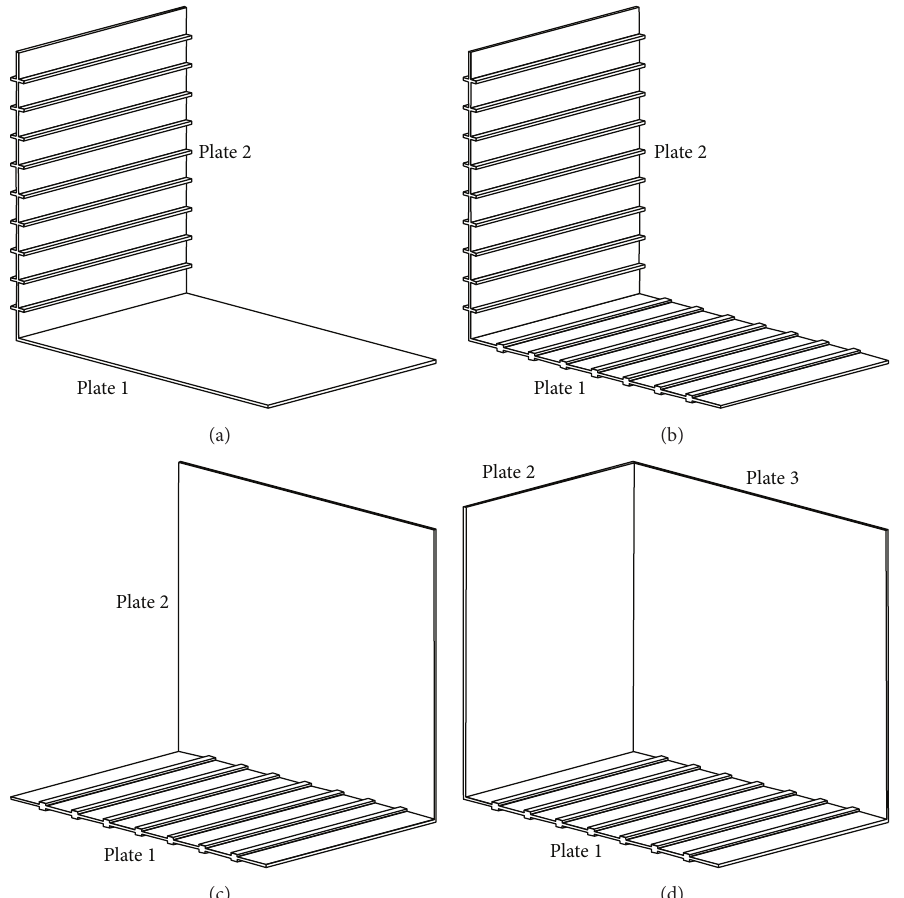
Figure 1: (a) L-junction A, (b) L-junction B, (c) L-junction C, and (d) three coupled plates.